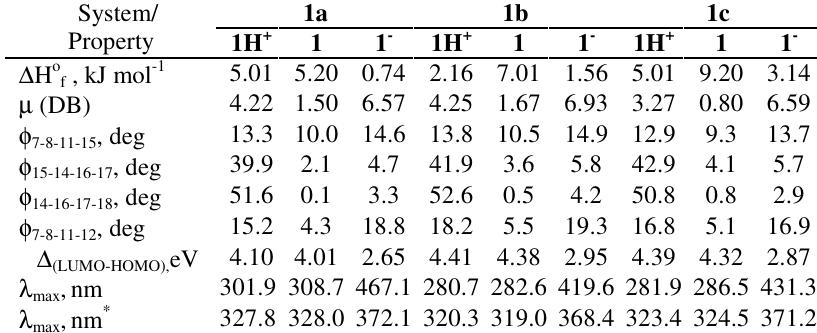
Figure 7. Torsional energy plots ( a ) over ( • )C(8)-C(11), ( (cid:1) ) C(14)-N(16), ( (cid:2) )N(16)-N(17) and ( (cid:3) ) C(18-C(19) bonds from -180 to +180 o and ( b ) double dihedral plot over C(14)- N(15)-N(16) bonds ( c.f . Figure 6 for numbering scheme for atoms) Table 2. Molecular modeled thermodynamic, dipole moment, dihedral angle ( φ ) and spectral data of 1.